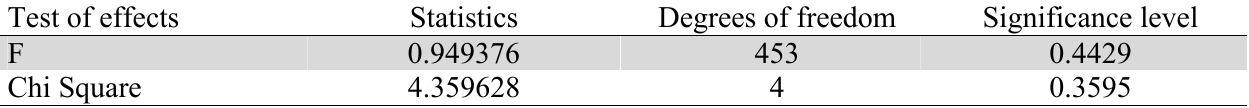
Chow test results for firms with high life cycle score Time fixed effects test